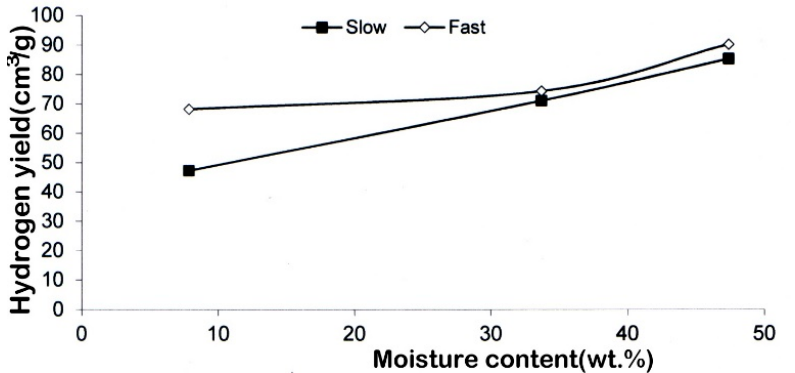
Figure 6. Effect of the moisture content on hydrogen yield under the slow and fast pyrolysis process. Table 2. The influence of the moisture content on the gas yield, conversion efficiency ( η ) and gas composition (40 L/h striping gas flow rate) and statistical processing of experimental data obtained for the hydrogen content in the gas fraction, depending on the moisture content of the walnut shells samples.